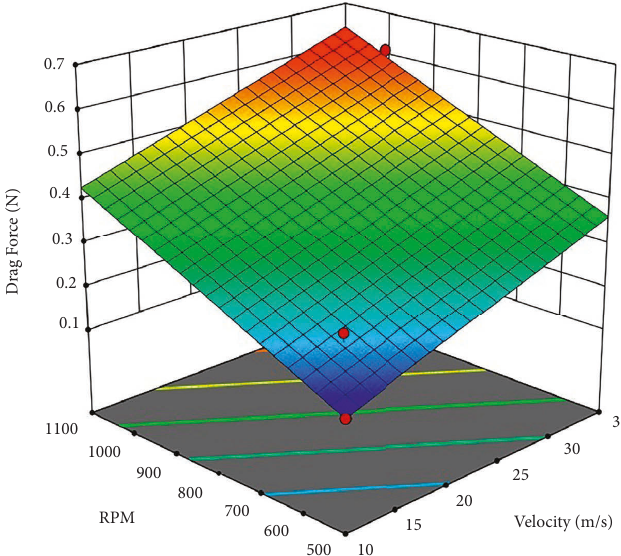
Figure 16: Drag force measured for the NASA SC(2)-0714 model.